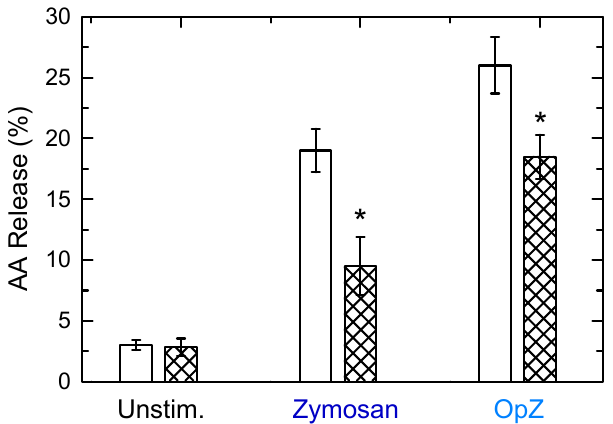
Figure 9. Effect of SKF98625 on macrophage AA release. The cells were left untreated (open bars) or pretreated (cross-hatched bars) with 10 µM SKF98625 for 30 min. Afterward, the cells were either untreated (unstim.) or stimulated with 1 mg/mL zymosan or 1 mg/mL OpZ (see x-axis). After 1 h, the extracellular media were removed and analyzed for 3H-radioactivity content. The data are expressed as mean values ± S.E.M. ( n = 6). * p < 0.05, significantly different from the corresponding incubations without SKF9625.